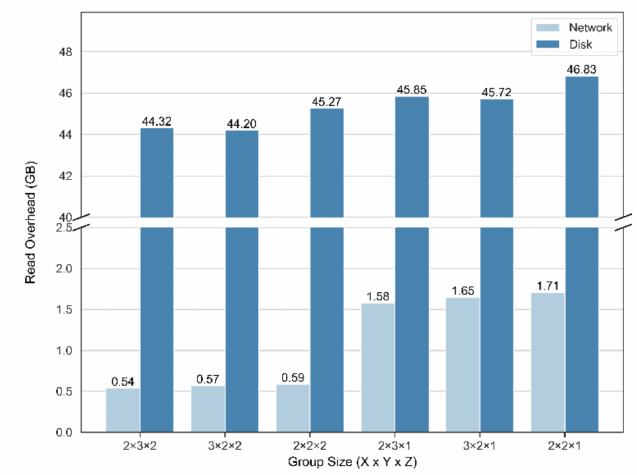
Figure 8. Statistics of read overhead for different group sizes in the group-based method. Overhead was significantly greater when group height was 1. With the same group height, group length and width had less impact on read